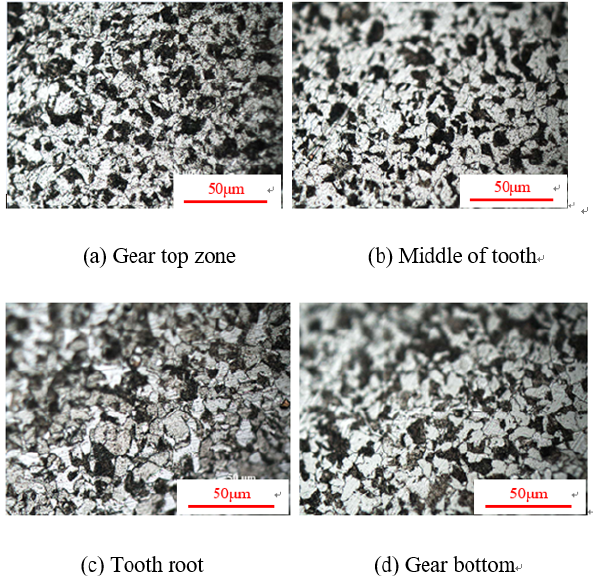
Figure 28. Microstructure of each area of gear (500X) (after opimization). Table 3. Hardness before and after